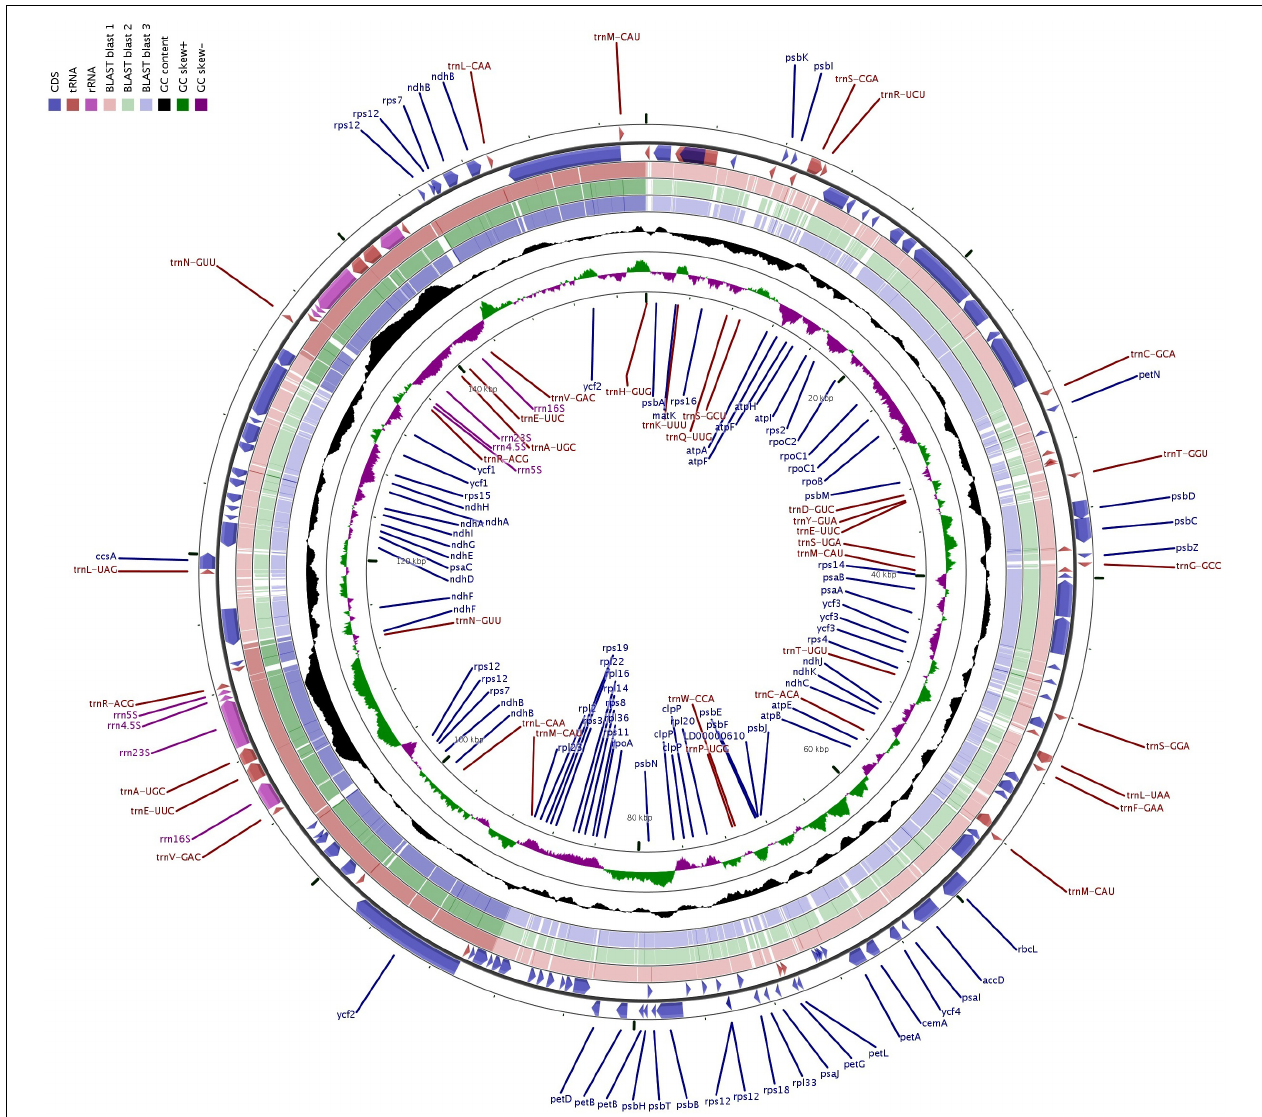
FIGURE 2 | CGView: Comparative genome analyses of chloroplast (cp) genomes of related plants of the family